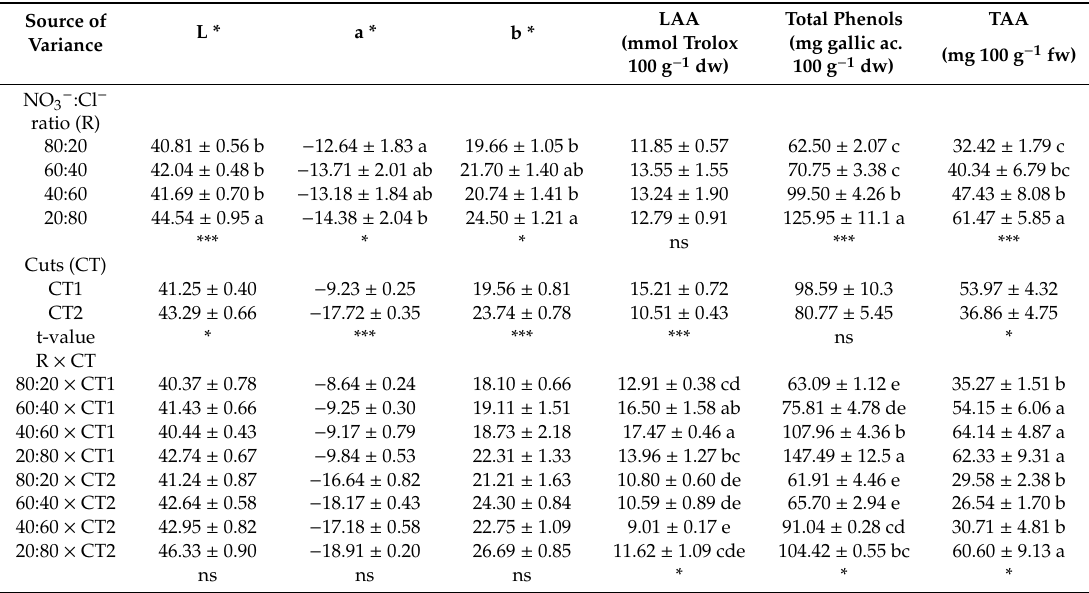
Table 4. Analysis of variance and mean comparisons for Hunter color parameters L * (brightness), a * (-a * = green) and b * ( + b * = yellow), lipophilic and hydrophilic antioxidant activities (LAA and HAA), total phenols and total ascorbic acid (TAA) of greenhouse basil cultivated under four NO 3 − :Cl − ratios (R) in the nutrient solution and harvested in two sequential cuts